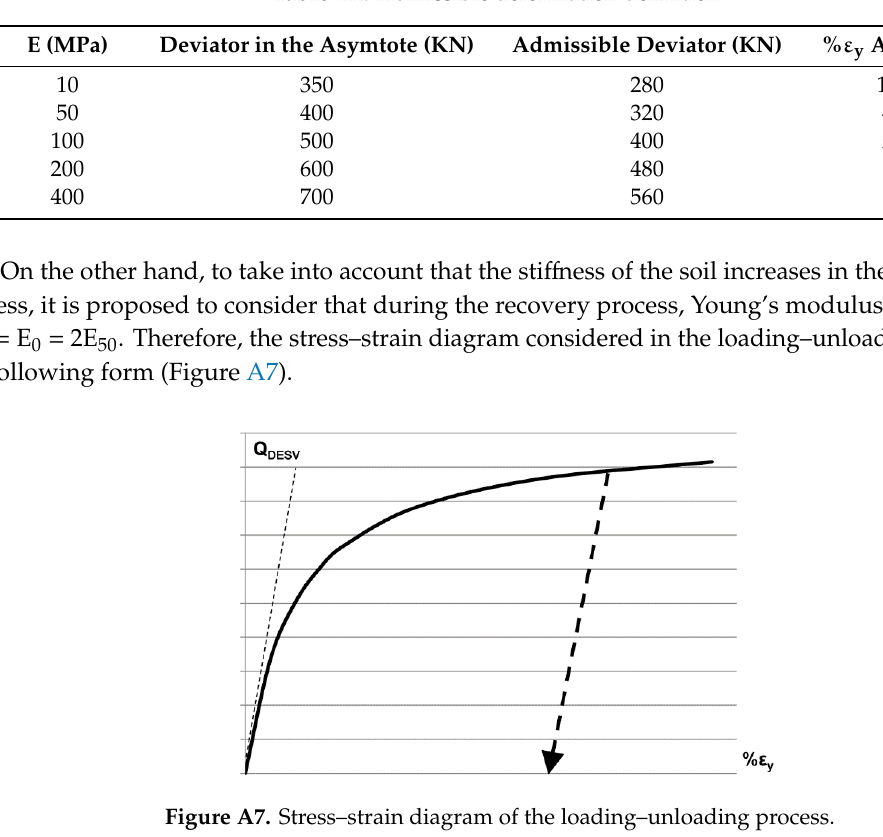
Figure A8. Process of hardening and softening produced by deformation, adapted from Atkinson [14].